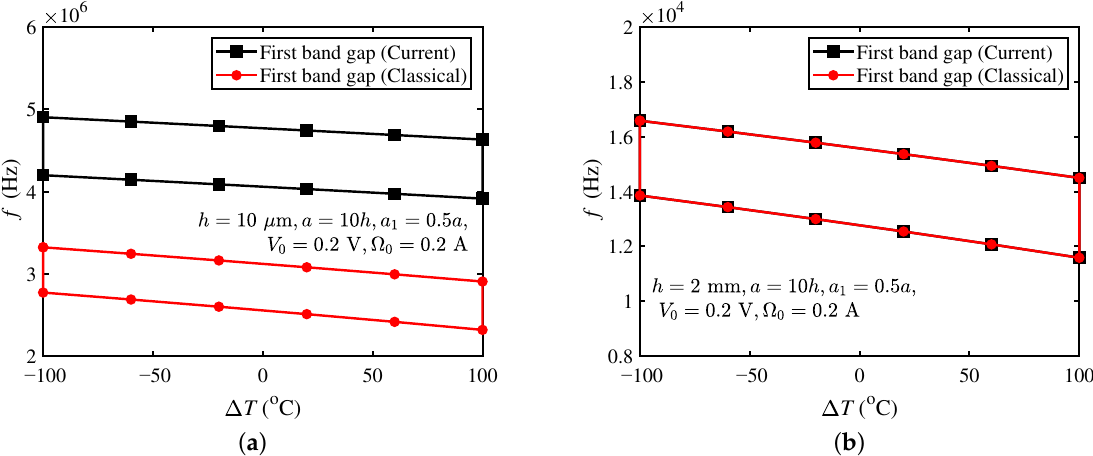
Figure 9. Bandgaps of current and classical models under different temperature changes with ( a ) h = 10 µ m, and ( b ) h = 2